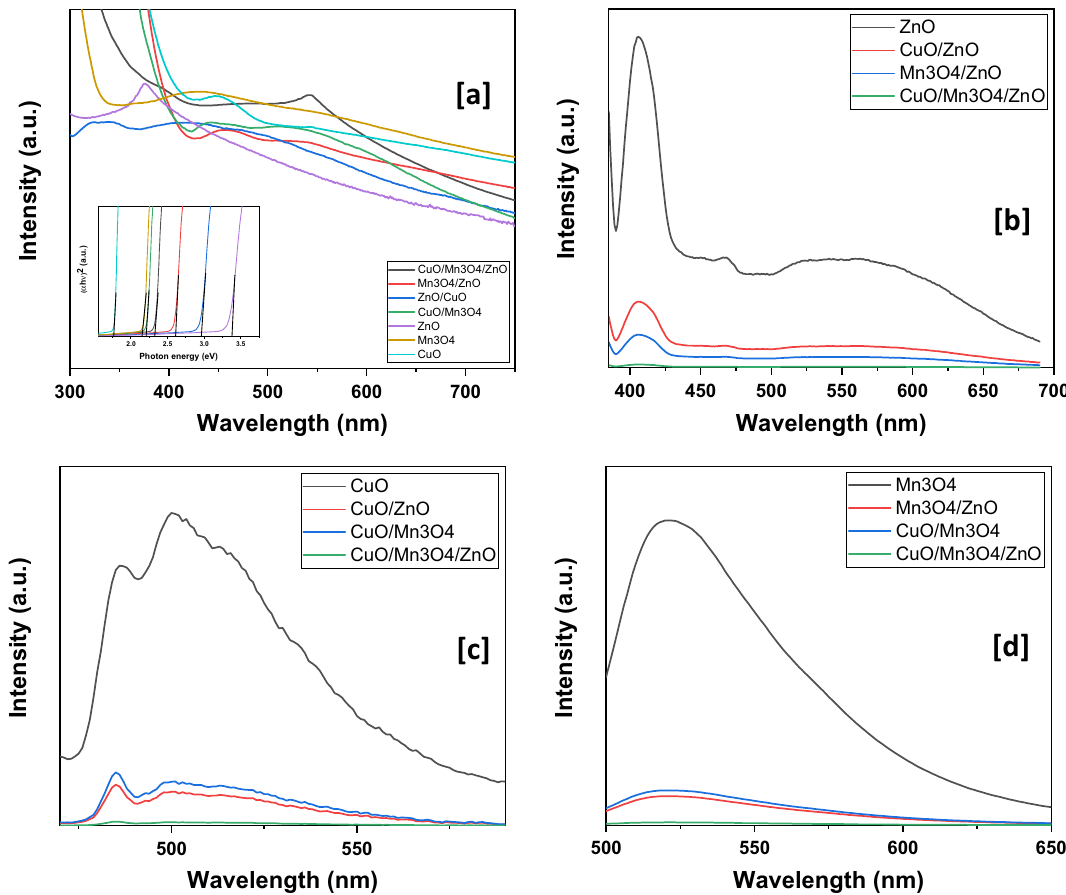
Figure 5. ( a ) UV–visible absorbance spectra of the various nano-scaled samples with an inset showing their respective Tauc’s plot for calculation of band gaps and ( b – d ) photoluminiscence